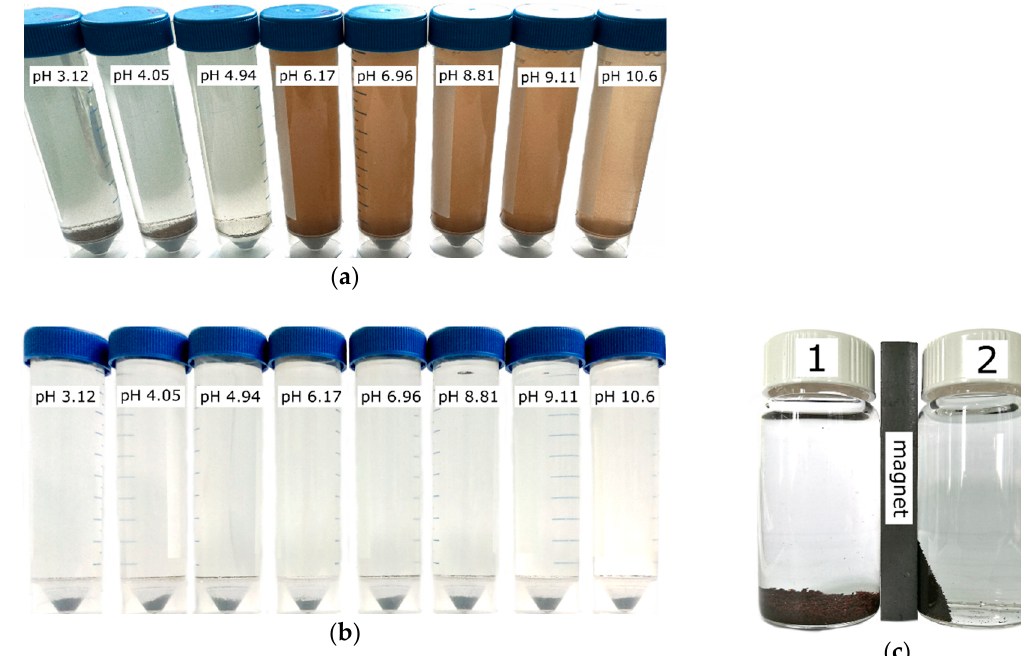
Figure 6. Visual evaluation of the composite sorbent suspensions in 0.1 M NaCl solution with different pH values after 1 week (sorbent weight is 0.2 g, volume of solution is 50 mL). Sorbents ( a ) 1A; ( b ) 3M; and ( c ) their magnetic properties (1A (1); 3M (2)).